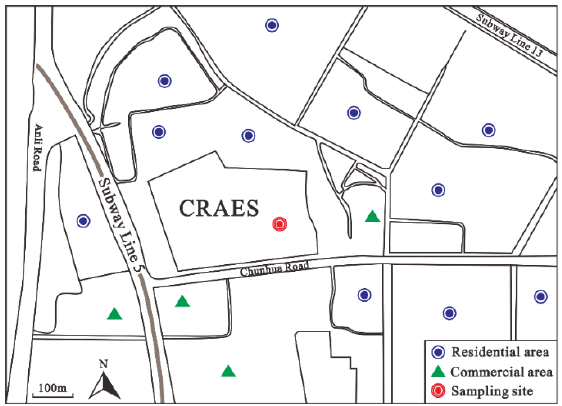
Figure 1. Location of sampling site and surroundings [21].